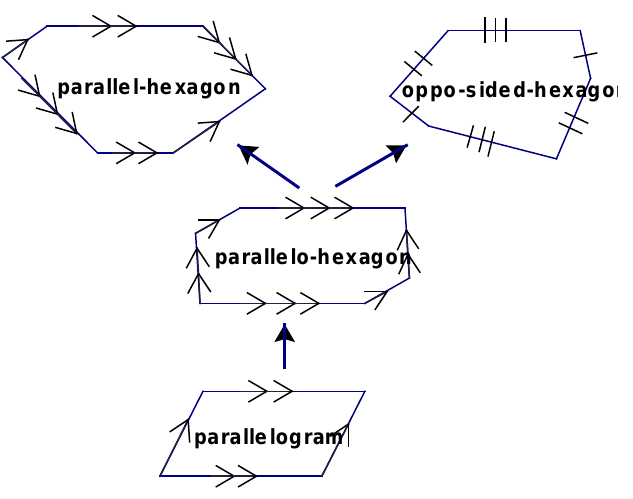
Figure 3: Generalising a parallelogram